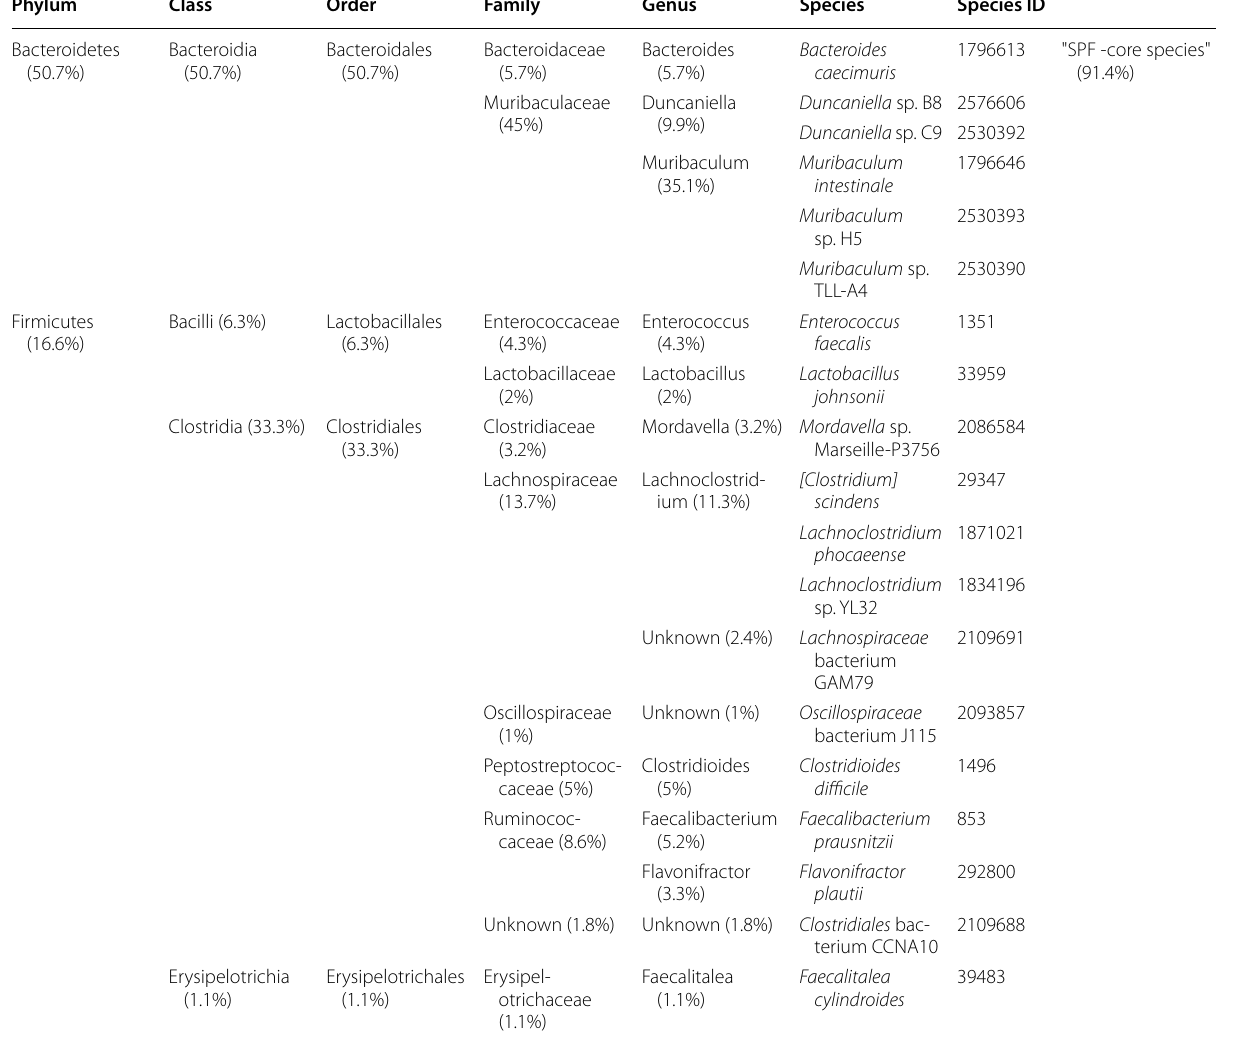
List of the nineteen species with an average abundance higher than 1% ("SPF-core species"), comprising 91.4% of bacteria present in the gut of the SPF mice. Taxonomy from phylum to specie level is shown. The different lines represent the species included in the list. For each species there are columns that describe the taxonomy (phylum, class, order, family, genus, species, Species ID)